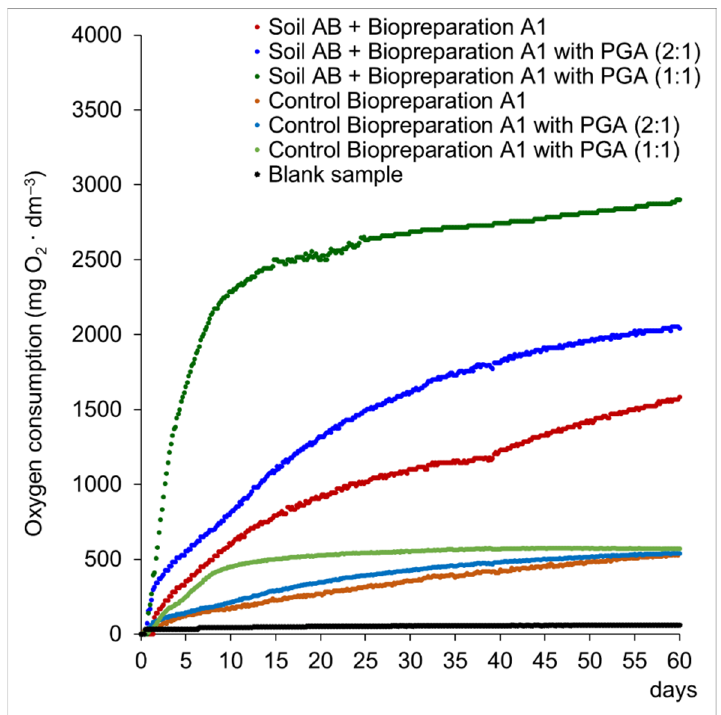
Figure 2. Dependence of the amount of oxygen consumed [mg·dm -3 ] on time in AB soil inoculated with biopreparation A1 and biopreparation A1 with γ -PGA addition. Control-sterile uncontaminated “pure” soil inoculated with biopreparation A1 and biopreparation A1 with γ -PGA. Blank sample is soil AB with distilled water.